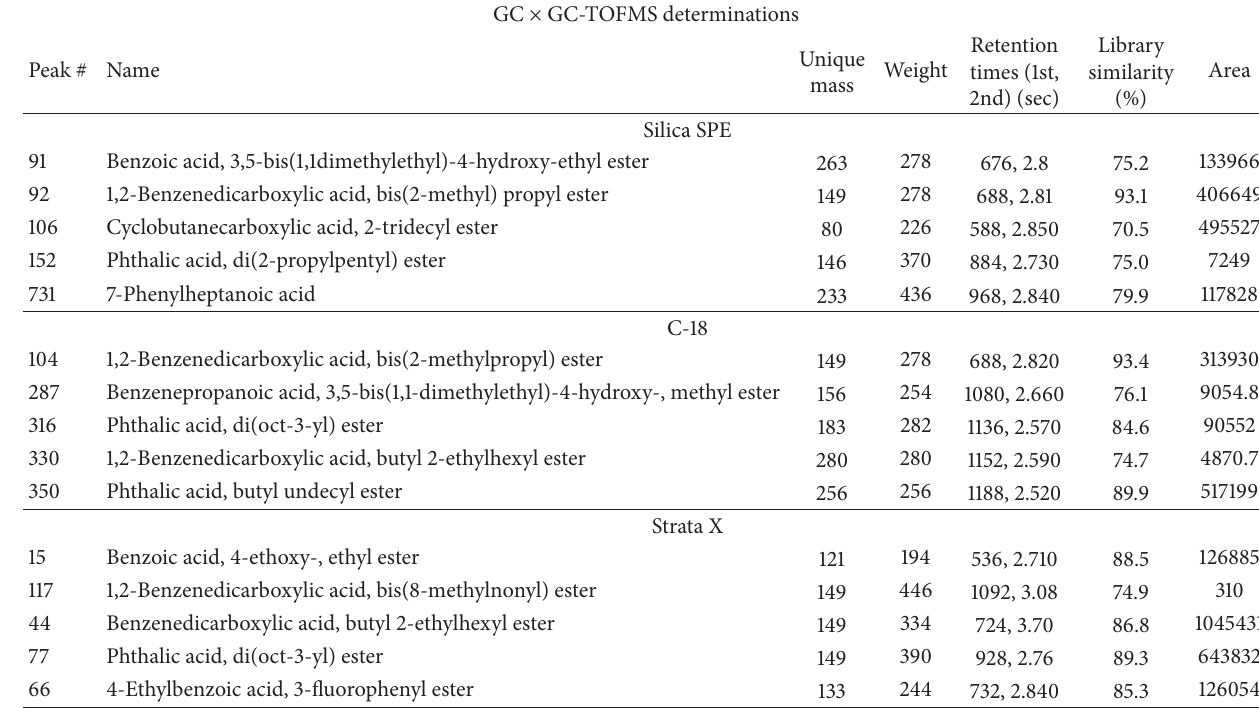
Table 2: Selected carboxylic acids extracted by silica, C-18, and Strata X.